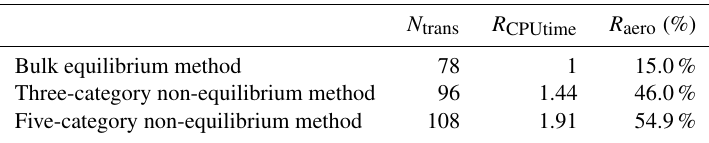
Table 5. Number of transport variables (gas plus aerosol attributes) ( N trans ) and ratios of the total CPU time to that of the bulk chemistry ( R CPUtime ), as well as ratios of CPU time of the aerosol process to that of the total processes 1 ( R aero ). N trans R